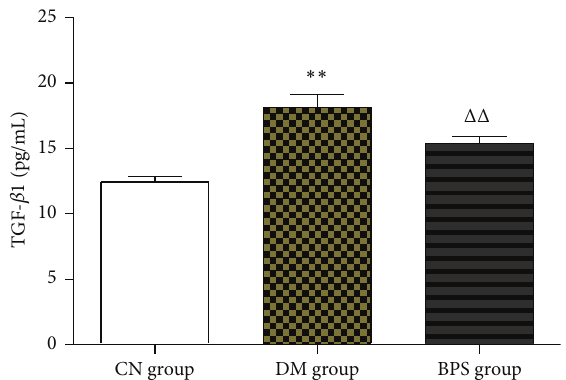
Figure5:TGF- 𝛽 1ineachgroup.ComparedwithCNgroup,thelevel of TGF- 𝛽 1 significantly increased in both BPS group and DM group; the difference was statistically significant ( 𝑃 < 0.01 ). Compared to DM group, the level of TGF- 𝛽 1 significantly decreased in BPS group ( 𝑃 < 0.01 ).